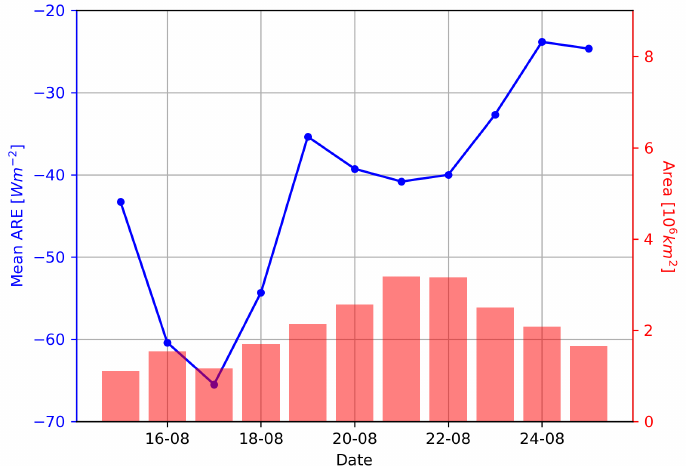
Figure 7. Time evolution of the ARE regional mean values (blue line) over the pixels available (transformed into an area, red bars) in the region considered (60 ◦ N–80 ◦ N, 110 ◦ W–0 ◦